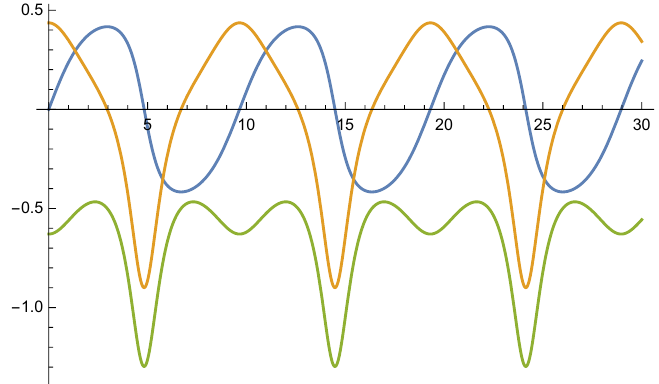
Figure 1 . The angular velocities _ (cid:18) ( t ), _ (cid:30) ( t ) and _(cid:10)( t ) for a particular solution, characterized by ( J 1 ; J 2 ; J 3 ) = ( 1 ; 1 ; 1 ) and J 2 = 1 . The blue curve shows _ (cid:18) , the yellow one _ (cid:30) , the green one 2 3 4 2